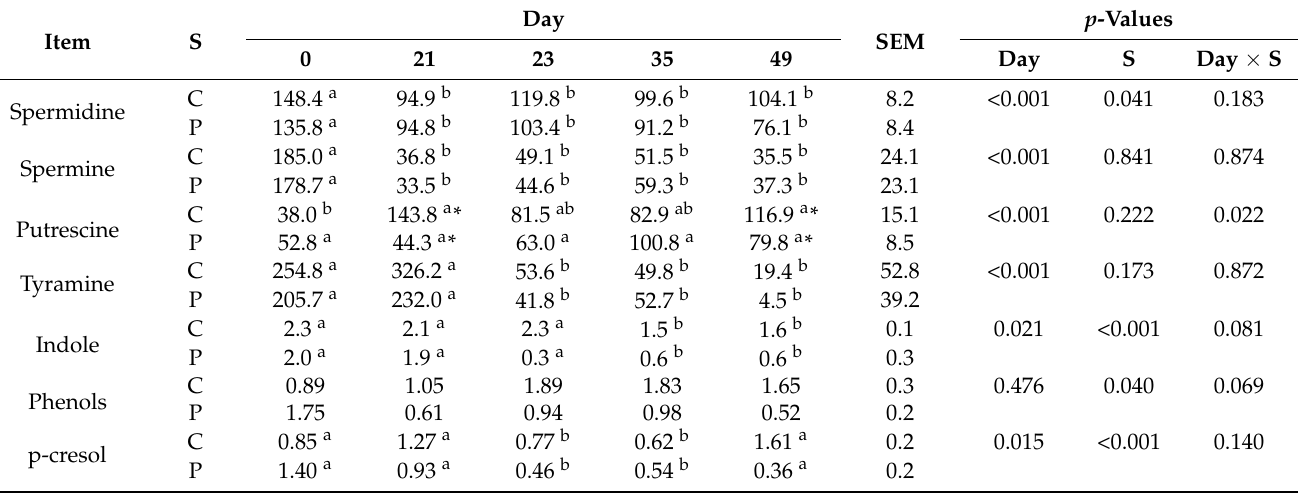
higher protein and fiber diet (days 23 to 49) without (C) or with (P) yeast supplementation (S).